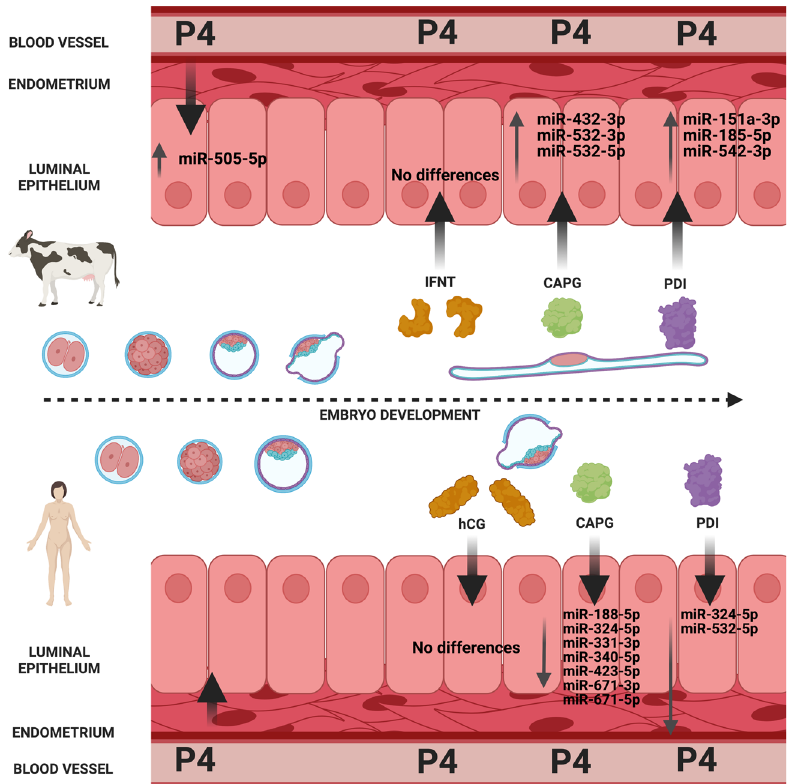
Fig. 1 Regulation of core miRNA toolkit by early pregnancy markers. The endometrial epithelium of bovine (super fi cial implantation strategy) (top panel) or human (invasive implantation strategy) (bottom panel) are regulated by molecules important for endometrial function in early pregnancy in eutheria (P4: progesterone; hCG: human chorionic gonadotrophin; Interferon Tau: IFNT; Macrophage capping protein: CAPG, and protein disul fi de isomerase: